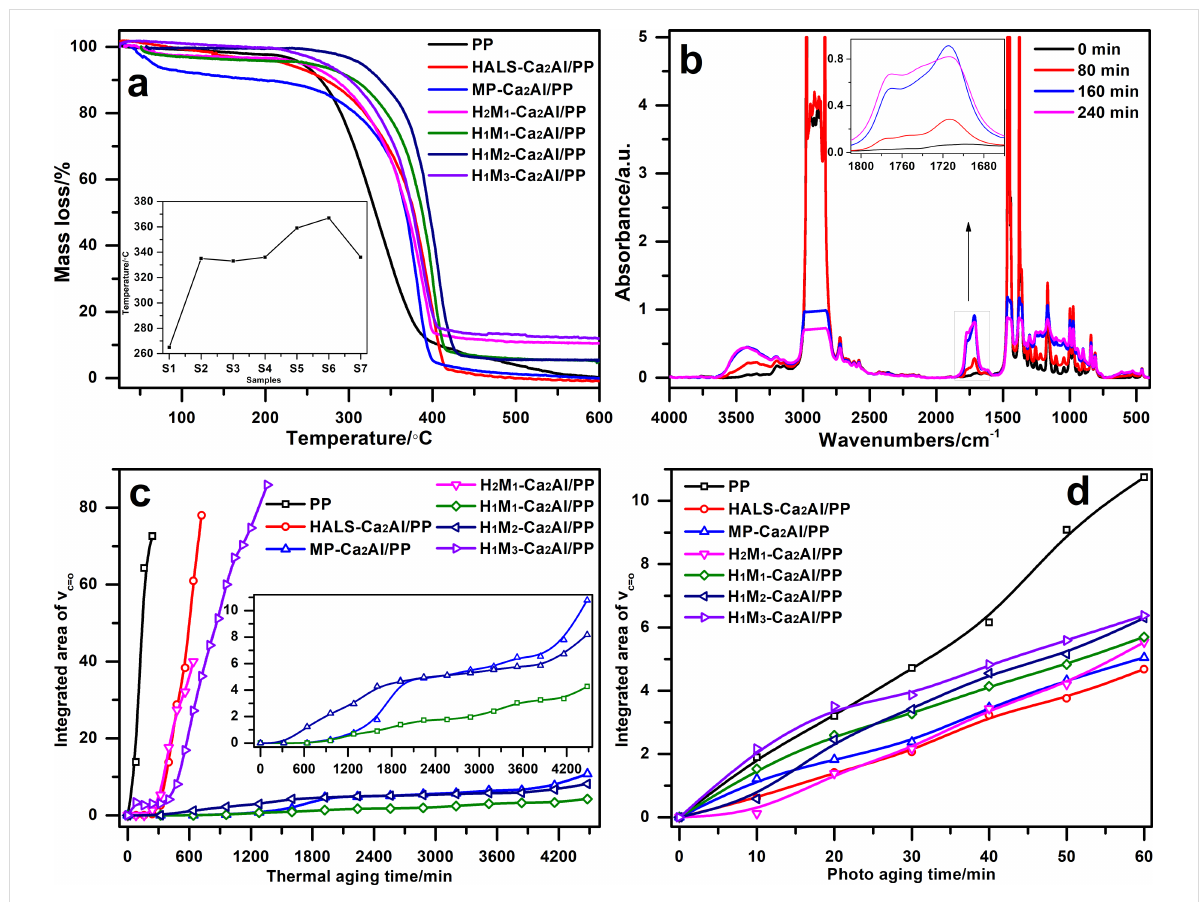
Figure 8: (a) TGA curves of H n M n ′ -Ca 2 Al/PP composites. (b) FTIR spectra of PP after different periods of thermal aging. (c) Thermal aging and (d) photo-oxidation aging of H n M n ′ -Ca 2 Al/PP